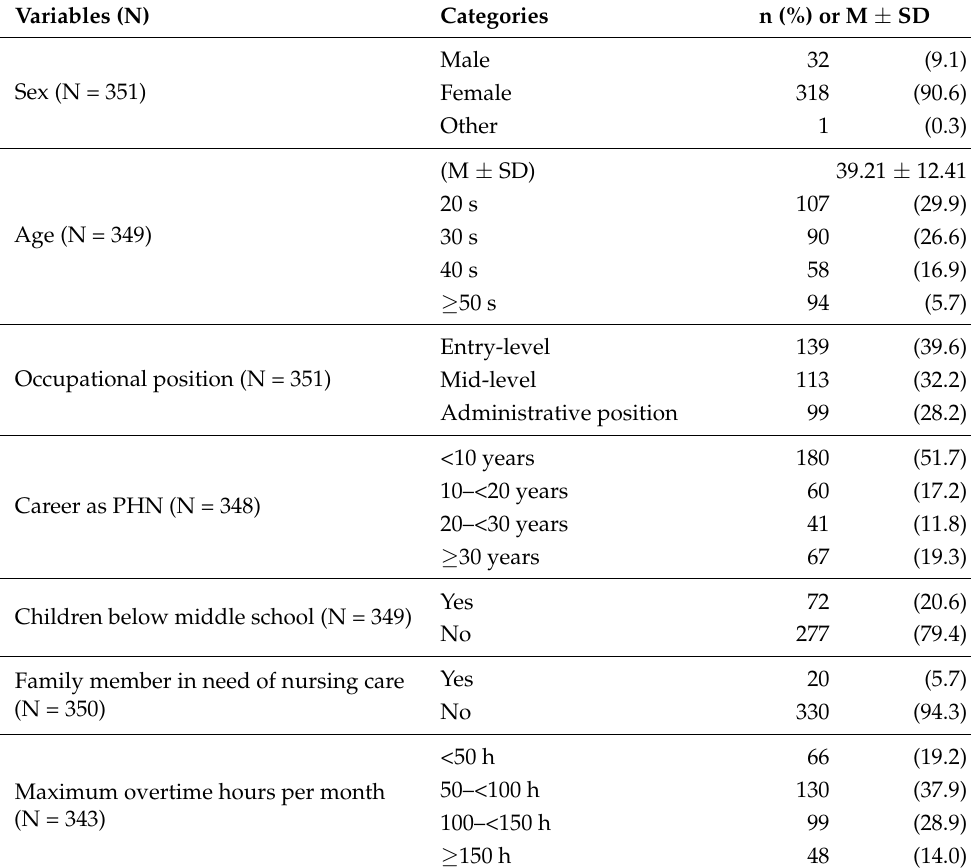
Table 1. Socio-demographic data of the